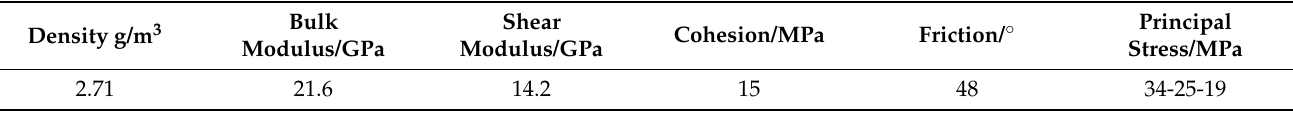
Table 7. Calculation parameters of the Wulaofeng tunnel model.